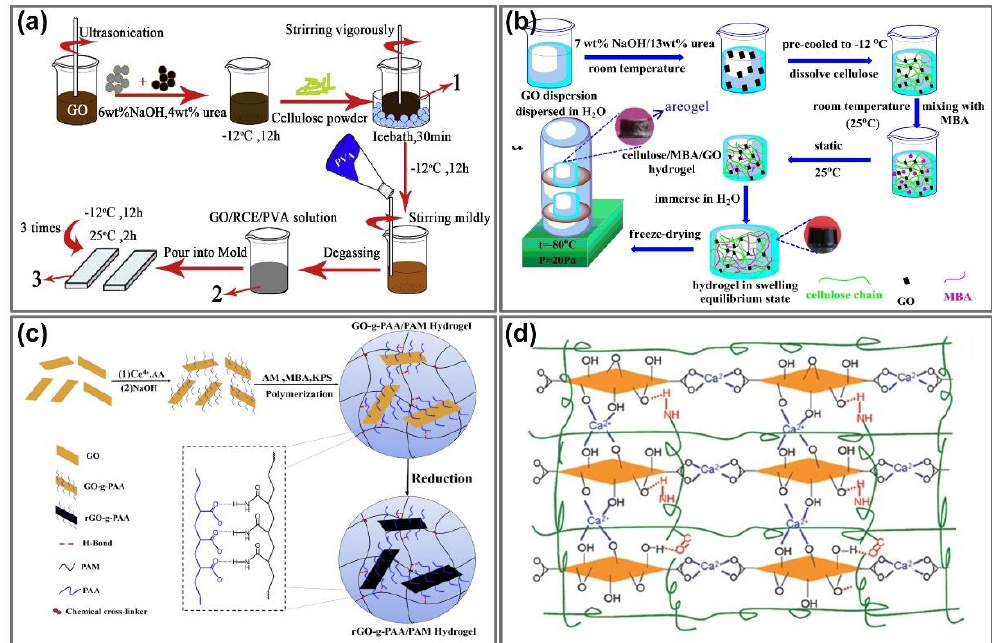
Figure 2. Graphene-immobilizing hydrogel preparation process. ( a ) Fabrication of GO–RCE/PVA ternary hydrogels by performing the freeze/thaw protocol. Adapted with permission from [53]. ( b ) Synthesis of cellulose/MBA/GO hydrogels by addition of MBA as a cross-linker. Adapted with permission from [66]. ( c ) Fabrication of GGels by in situ reduction of PAA grafted GO in the PAM matrix. Adapted with permission from [75]. ( d ) Schematic models of the GO/PAM hydrogel including a Ca 2+ coordination-induced GO network (blue), chemically cross-linked PAM network (green) and hydrogen bonds between GO and PAM (red). Adapted with permission from